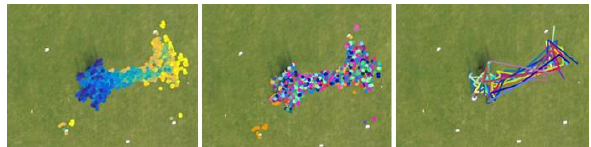
Figure 9. Visualisation styles side by side: Gradient (left), points (middle), lines (right), on the result of the 'Narrow Passage' scene